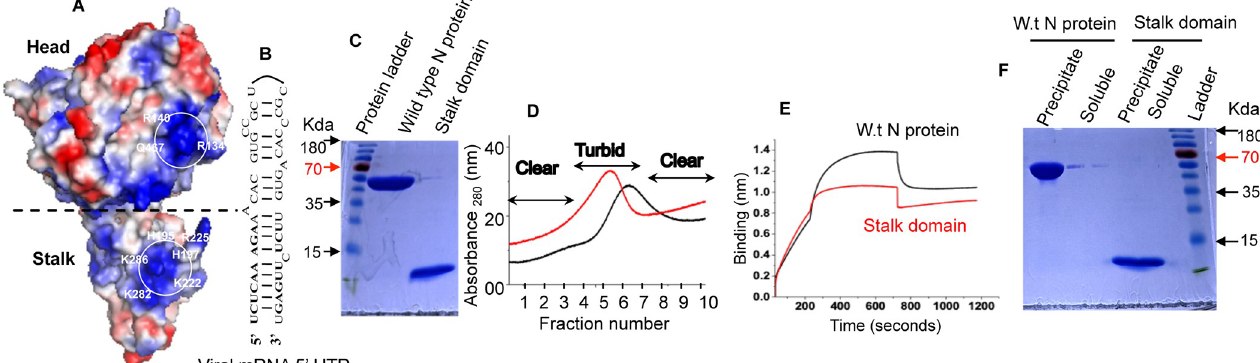
Fig 1. ( A ) A modeled 3D structure of CCHFV N protein showing head and stalk domain. The positive and negative charged surfaces are colored in blue and red, respectively. This model was previously reported in [20] where the amino acid composition of RNA binding sites in the stalk and head domains is discussed. ( B ) A panhandle like secondary structure formed by the partially complementary nucleotides of the 5’ UTR of the CCHFV S-segment derived mRNA. ( C ) Elution profile of wild type N protein (red) and stalk domain (black) from the HisTrap NiNTA column using the AKTA pure protein purification system (GE Healthcare). The clear and turbid fractions are shown by arrows. ( D ) The clear fractions 2 and 9 from panel C were combined and tested for RNA binding activity. Shown are the Biolayer interferometry (BLI) sensograms of wild type N protein (black) and stalk domain (red), demonstrating the association and dissociation kinetics for protein-RNA interaction. ( F ) The precipitated wild type N protein and stalk domain were briefly centrifuged at room temperature. The protein in the precipitated pellet and the supernatant (soluble) were examined by SDS-PAGE.